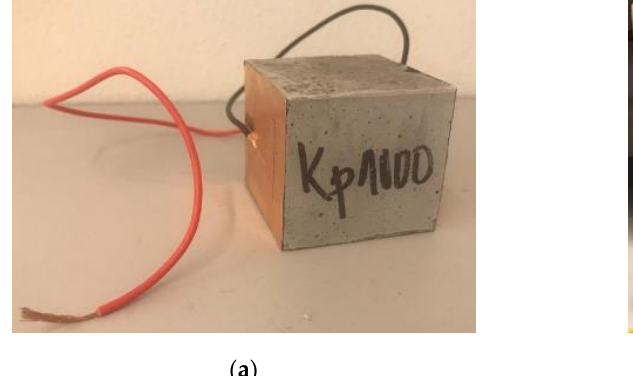
Figure 5. ( a ) Sample attached by electrodes; ( b ) LCR bridge for measurements of AC electrical properties.